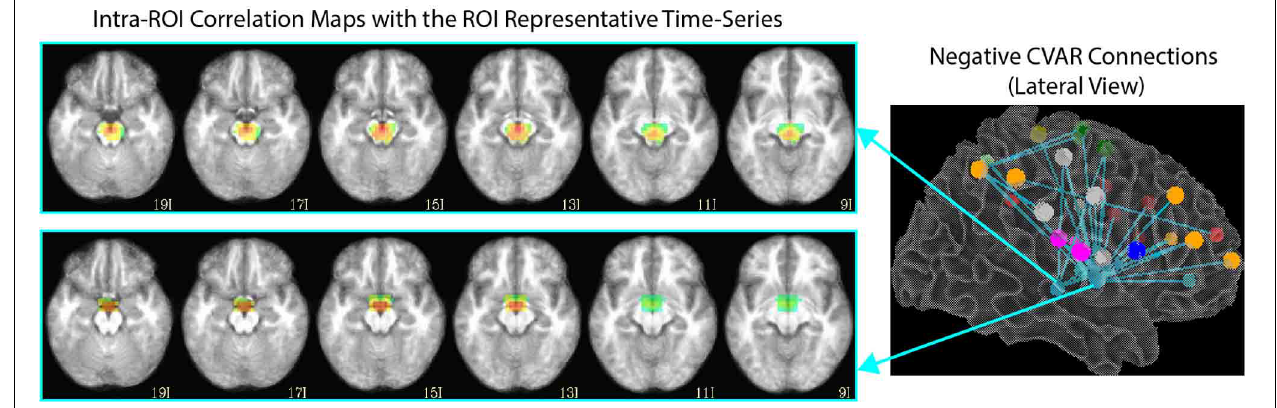
FIGURE 12 | Intra-ROI correlation maps to the ROI representative time-series for 2 ROIs of interest. Voxels with the highest correlation to the representative time series (red color) are those in and around the third